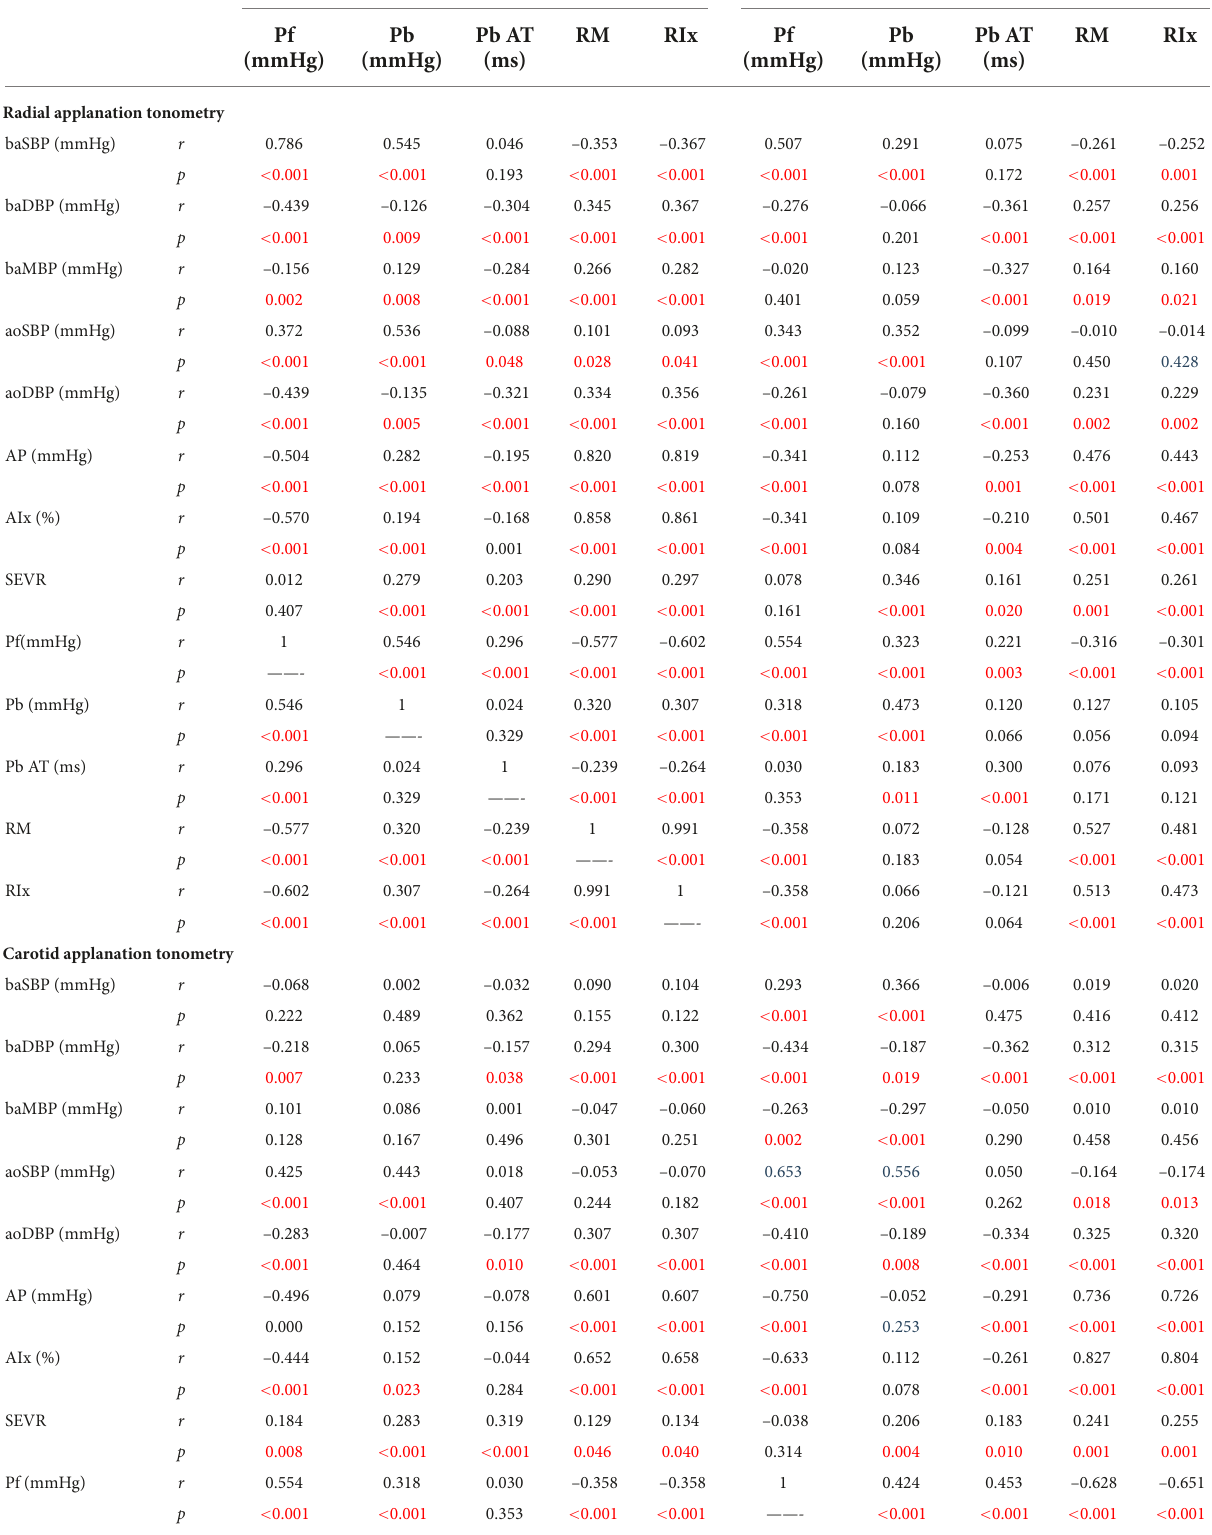
TABLE 2 Association between hemodynamic and waveform derived